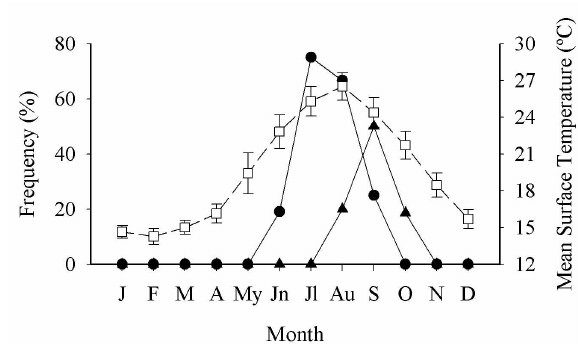
Fig . 5. – Monthly percentage of ripe and spawning ( l ) and spent ( p ) vitellogenic gonads of Epinephelus marginatus females and